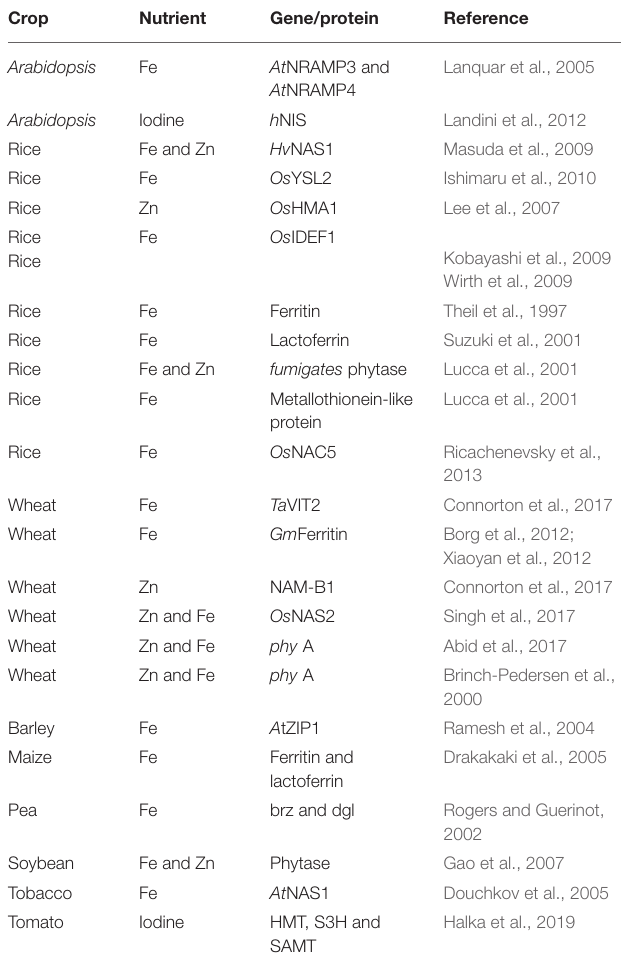
TABLE 1 | Transgenic biofortified crops with enhanced iron, zinc, and iodine.